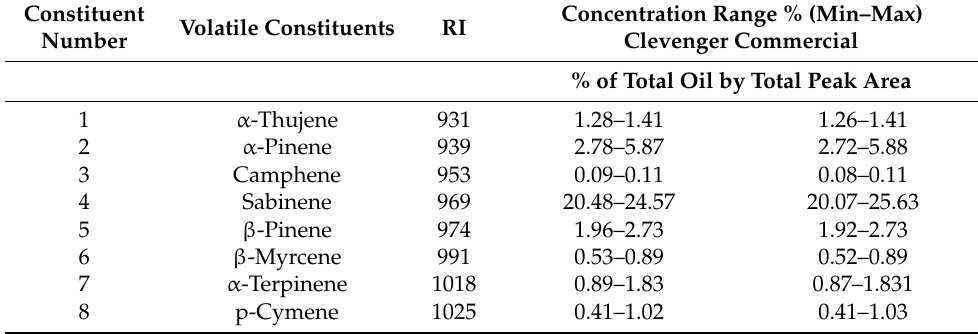
Table 7. Average concentration of the 45 Juniperus sabina constituents (% of the total oil in the dried bimoass) extracted using two different methods: hydrodistillation (in a Clevenger apparatus) and steam distillation (in a semi-commercial